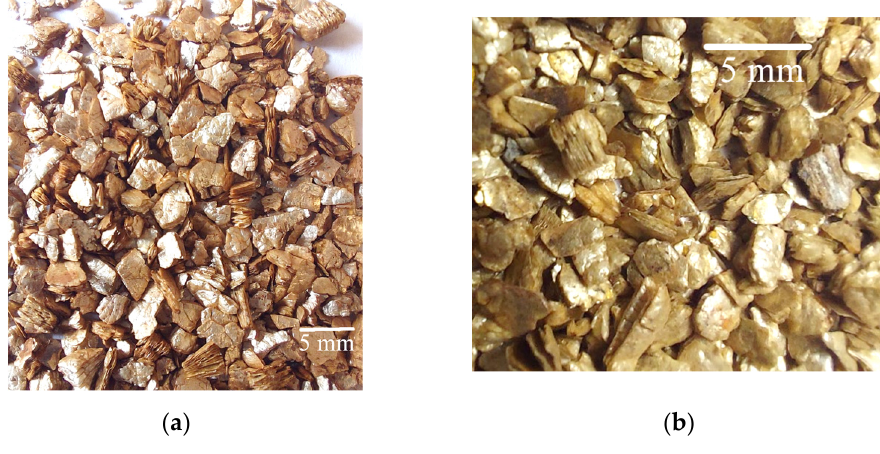
Figure 4. Aspect of U-900 ( a ) and U-MW ( b ).